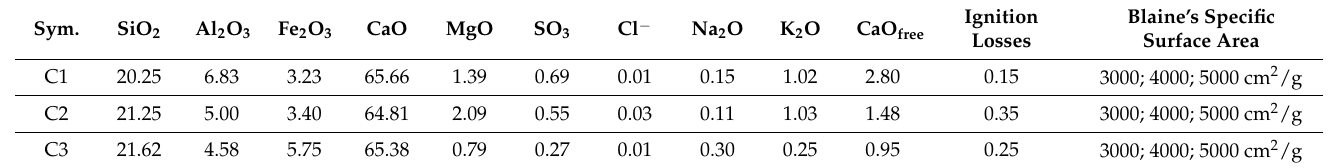
Table 3. Chemical composition of Portland clinkers, mass %.